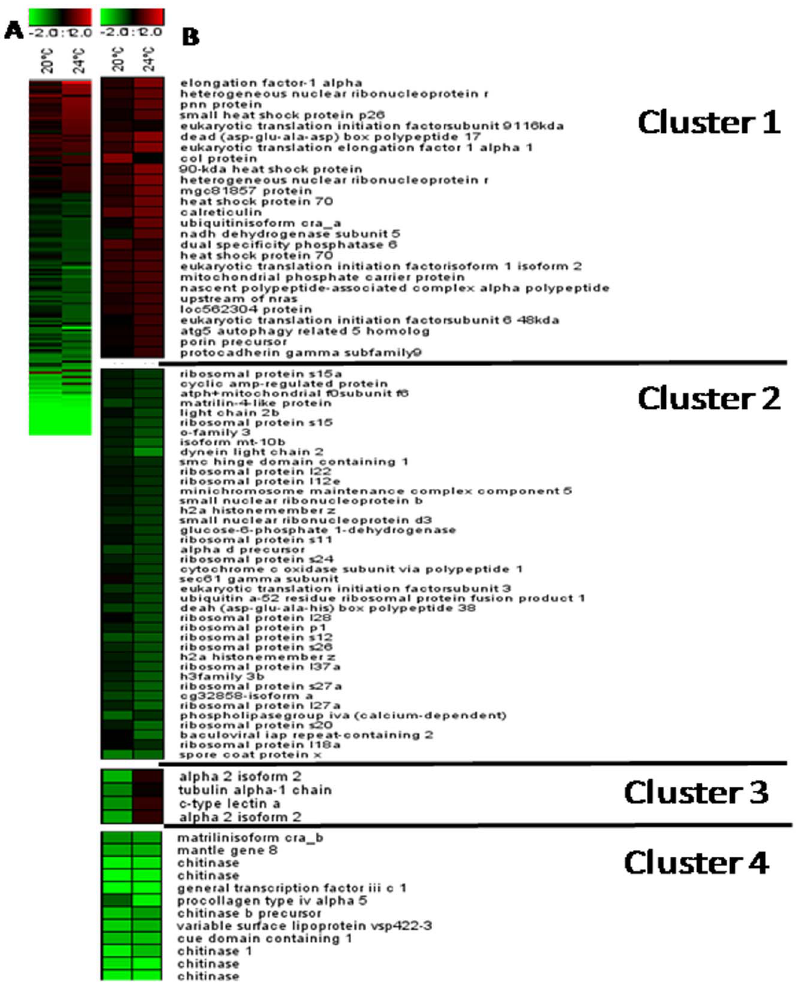
Figure 4. Mytilusgalloprovincialis gene expression profiles of digestive gland tissue along with the temperature gradient. The heat map (A) (Pearson correlation, complete linkage algorithm) and the decomposition of gene expression profile (B) report the log2 relative expression level with respect to the selected reference condition (16 u C). 161 differentially expressed genes were generated in at least one condition. Microarray data were analyzed using the Linear Mode for Microarray Analysis (LIMMA) software as described in [23]. B statistics with adjusted p value, 0.05 and B.0 were used as threshold for rejection of the null hypothesis (no variation). Supporting information to Figure 2 is present in Table S2 and Table S3. The k-means algorithm was used for the computation of different gene expression trends in the set of 161 unique genes whose expression was modulated in female gills along with the temperature gradient (table S3). K-means is an iterative procedure aimed to reduce the variance to a minimum within each cluster [24;25].